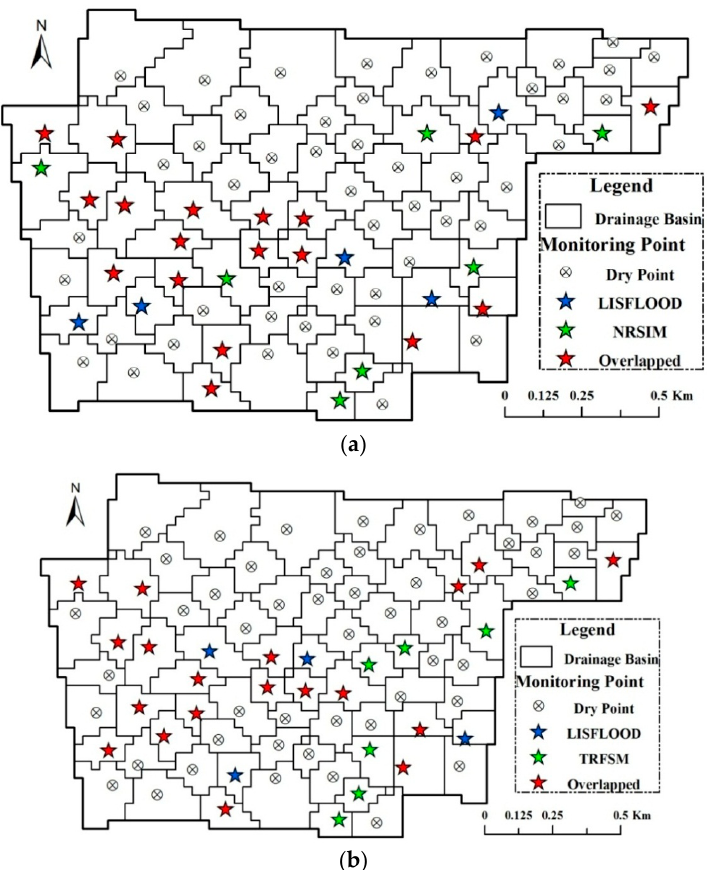
Figure 11. Comparison of inundation extent between LISFLOOD and: NRSIM ( a ); and traditional rapid flood spreading model (TRFSM) ( b ) using a 30 ‐ m resolution DEM.